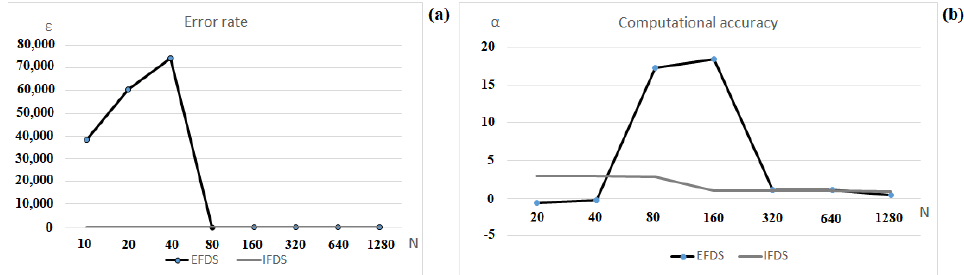
Figure 4. ( a ) Error ε , ( b ) computational accuracy α .